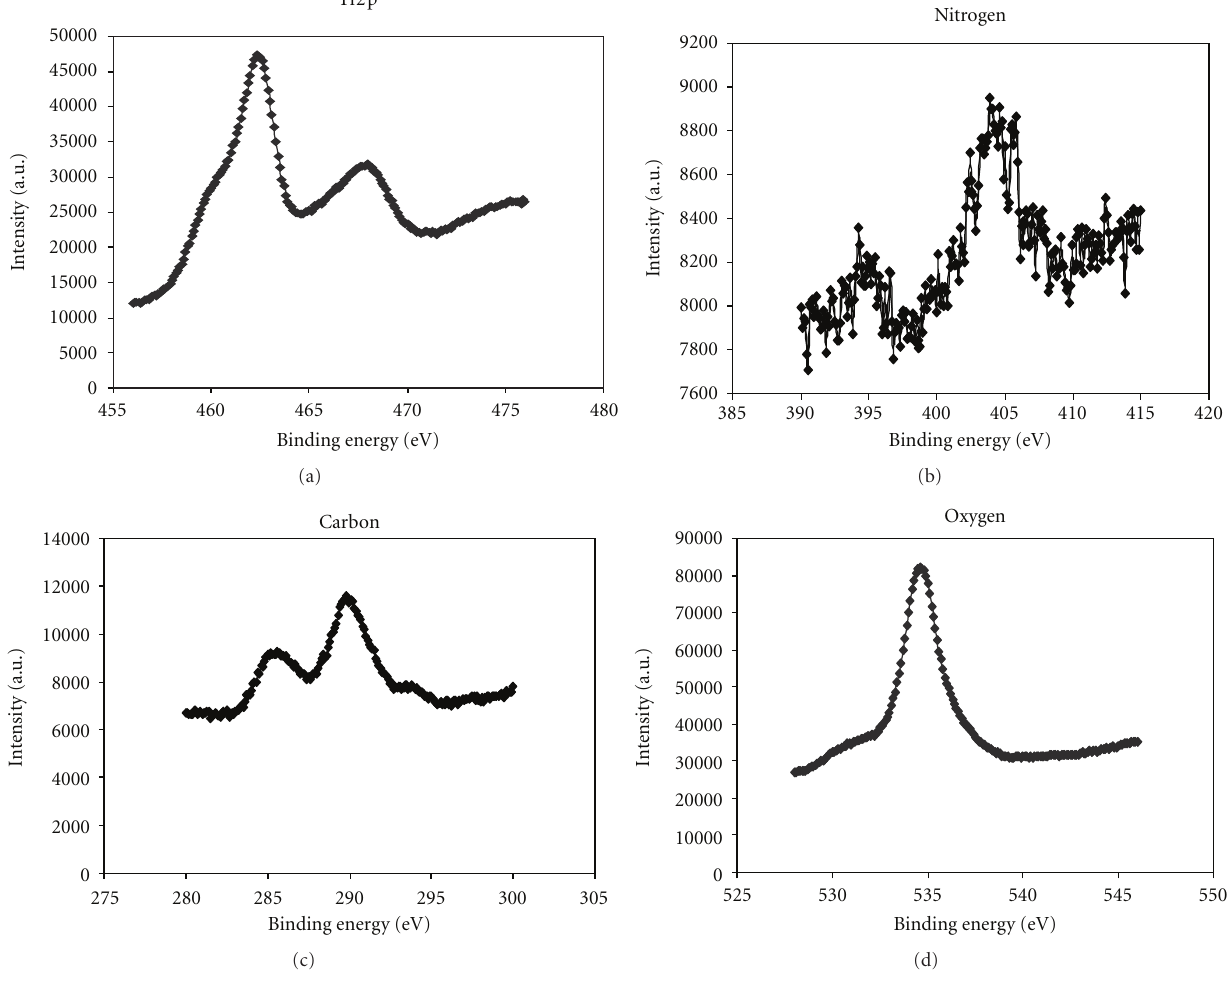
Figure 8: XPS of N-doped mesoporous